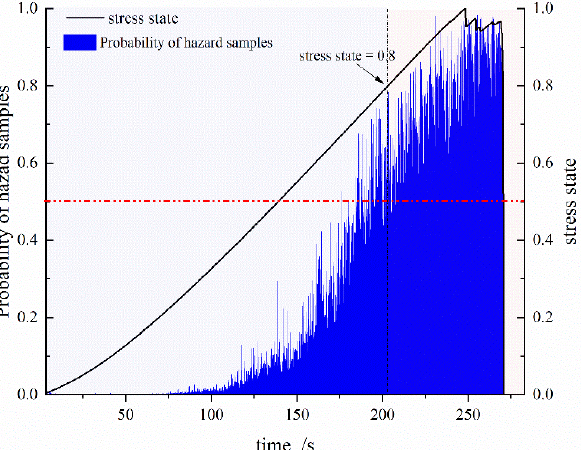
Figure 9. Probability value that AIEFPC predicts the AE sample is a hazard sample at an aD8-5 coal sample during uniaxial compression.